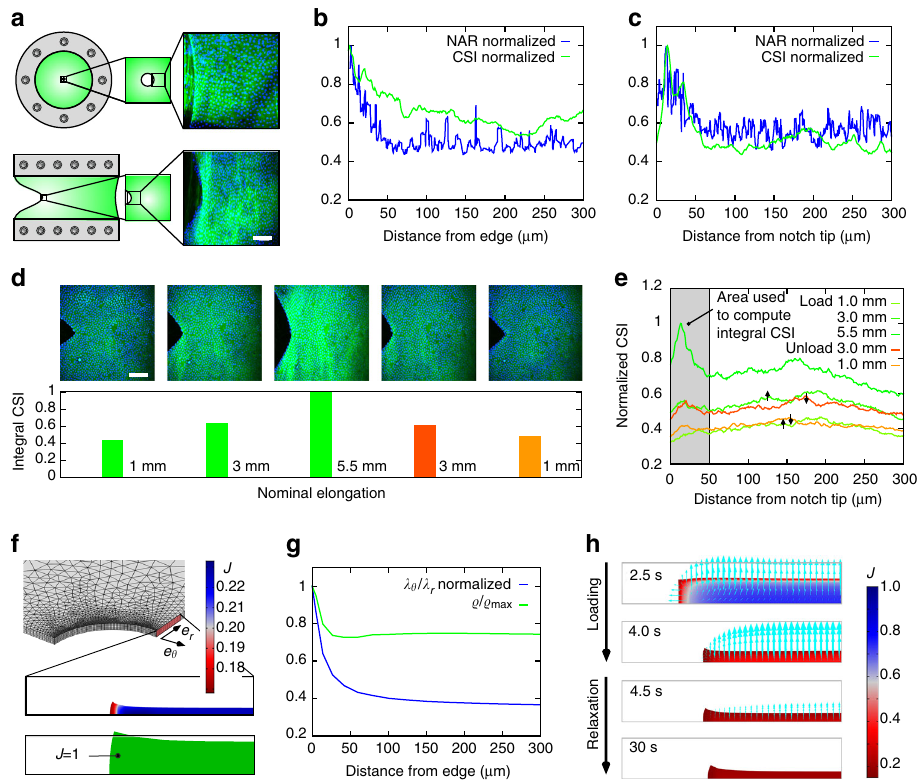
Fig. 4 Reinforcement and stress shielding in the near fi eld of defects. a In fl ation and fracture testing set-ups and multiphoton microscopy (MPM) images of human amnion (hAM) samples with circular or notch-like defects. Scale bar : 100 μ m. b , c Near fi elds of a circular defect at 5.6 kPa in fl ation pressure ( b ) and a notch at 6 mm nominal elongation ( c ). Normalized nuclear aspect ratio (NAR) and collagen signal intensity (CSI) rapidly drop to their far- fi eld levels with distance from the defect edge/notch tip. (One representative hAm sample out of n = 3, respectively). d Reversible formation and dissolution of reinforcing structures close to the notch tip during a load cycle, quanti fi ed by normalized integral CSI over 50 μ m. Scale bar : 100 μ m. e Reversibility of collagen densi fi cation in near and far- fi eld of the defect during loading and unloading. f – h Simulation results for membrane with circular hole rapidly stretched and kept at constant far- fi eld strain of 8% (One octant shown). f Volume change J ( top ) and deformed state following from the assumption of incompressibility ( bottom ). g Circumferential to radial stretch ratio and density, normalized by their values at the defect edge, showing a rapid drop. h Ef fl ux of water ( arrows ) and volume change J over time ( color bar